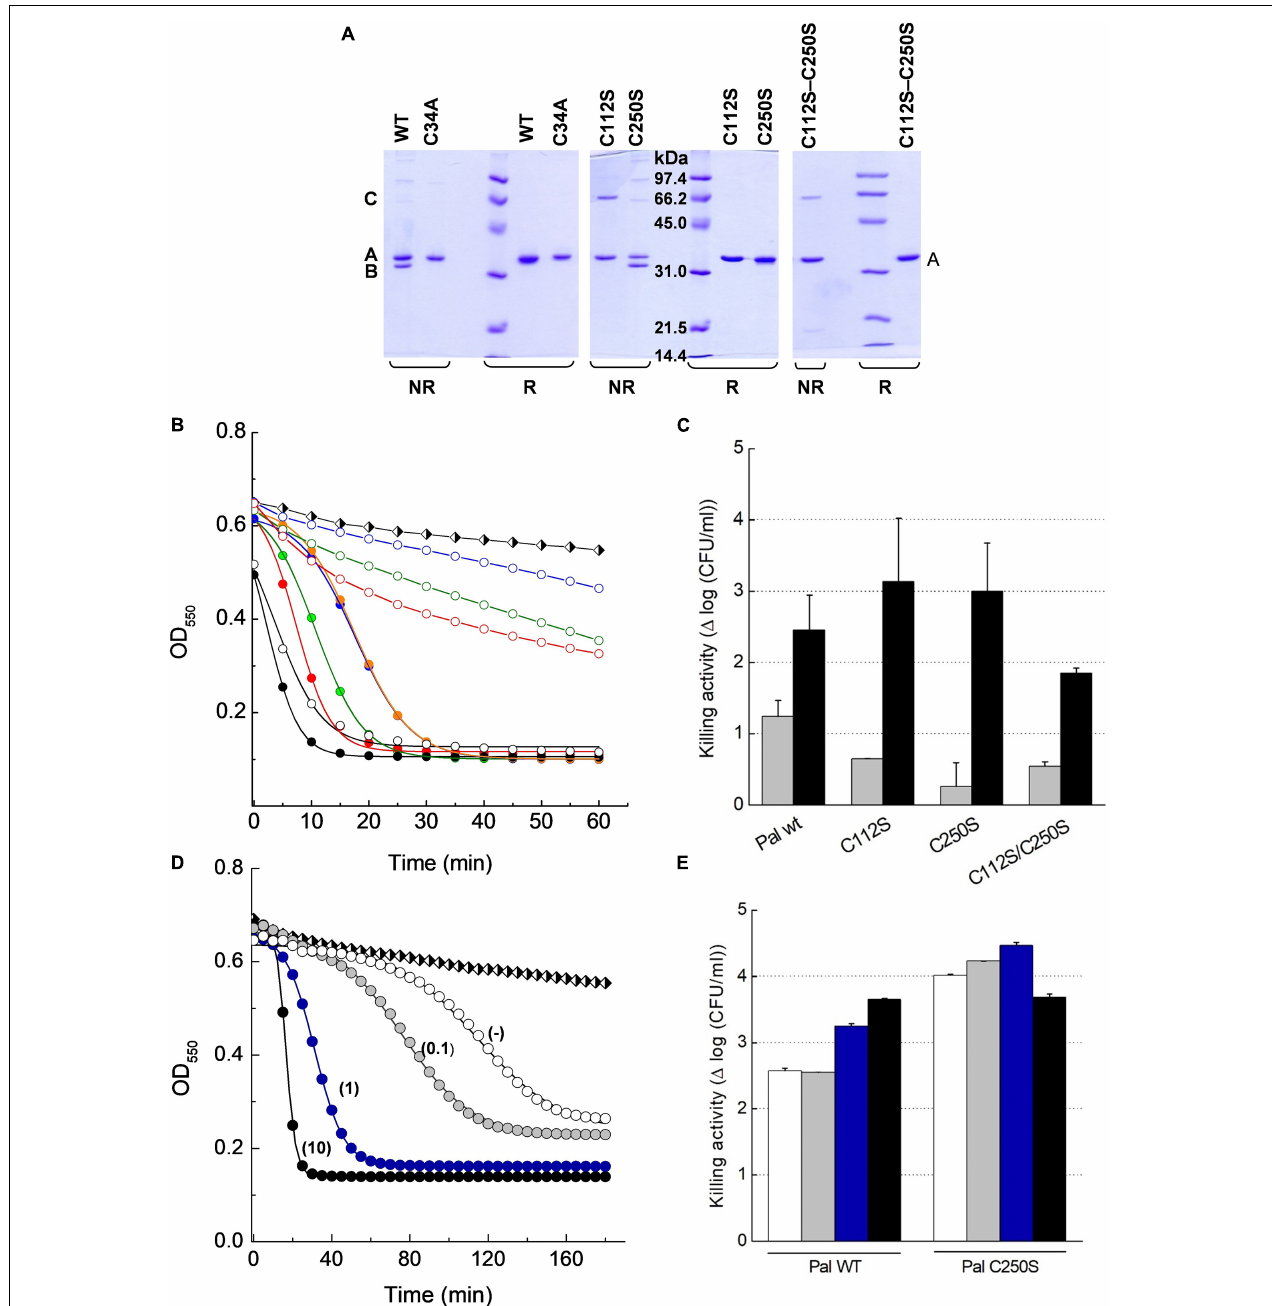
FIGURE 8 | Insight on DTT effect on Pal lytic activity. (A) SDS-PAGE analysis of Pal WT and its Cys mutants under reducing (R) and non-reducing (NR) conditions. Samples pretreated with iodoacetamide were incubated in sample buffer with (SB β ) and without (SB) β -mercaptoethanol for 3 min before the analysis. Bands B and A correspond to the Pal monomer with and without an intramolecular Cys34–Cys112 disulfide bridge, respectively, and band C to a dimer with a Cys34–Cys34 intermolecular disulfide. (B) Lytic activity of Pal variants (5 µ g/ml) against pneumococcal R6 strain in PB and PB DTT 10 , pH 6.8, 37 ◦ C (open and solid symbols, respectively). Turbidity decay was monitored as a function of time for 60 min. Symbols and solid lines depict representative experimental data after correction for control decay and the fits to the Boltzmann sigmoid, respectively (black: WT; green: C112S; blue: C250S; red: C112S–C250S; C250S preincubated in PB DTT 10 : orange). Black and white diamonds in (B,D) illustrate control decay. (C) Killing activity of Pal variants in PB and PB DTT 10 (gray and black bars, respectively) in samples from (B) after 60 min incubation. Error bars represent standard deviations from two to three independent experiments each of them in triplicate. (D) Effect of DTT concentration (figure labels; mM units) in the lysis buffer on the lag period and the maximum velocity of R6 lysis by Pal C250S (5 µ g/ml) preincubated in PB DTT 10 . Symbols and solid lines depict representative data, and they mean as in (B) . (E) Killing activity of Pal WT and C250S mutant in samples from (D) after 3 h incubation (white, gray, blue, and black bars stand for no DTT ( − ), 0.1, 1, and 10 mM DTT, respectively). Error bars represent standard deviations from duplicates of a single